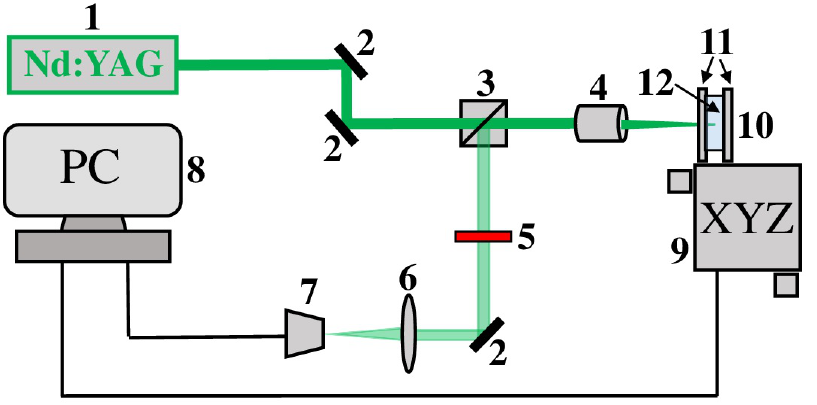
Figure 1. The LCLD experimental setup. 1—Nd:YAG 532-nm cw (continuous-wave) laser, 2—Al mirror, 3—optical separation cube, 4—microscope objective, 5—attenuation filter, 6—focusing lens, 7—web-camera, 8—personal computer, 9—XYZ motorized stage, 10—experimental chemical cell, 11—glass window (substrate), 12—chemical solution (see Table 1).